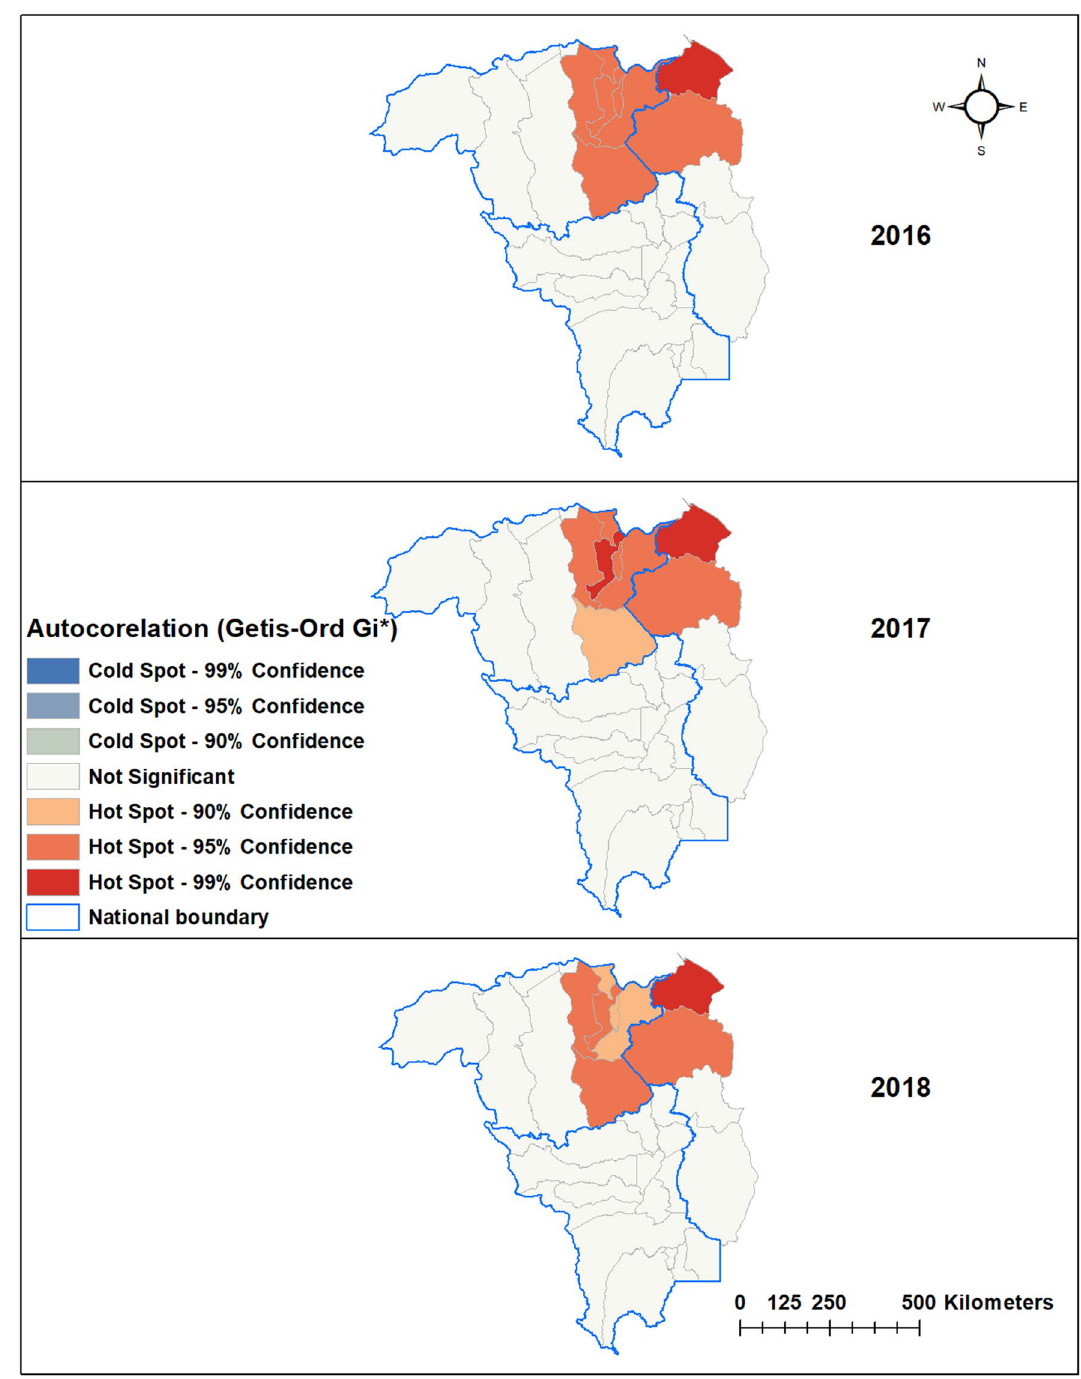
Figure 4. Hot spots (Getis-Ord Gi*) of Plasmodium